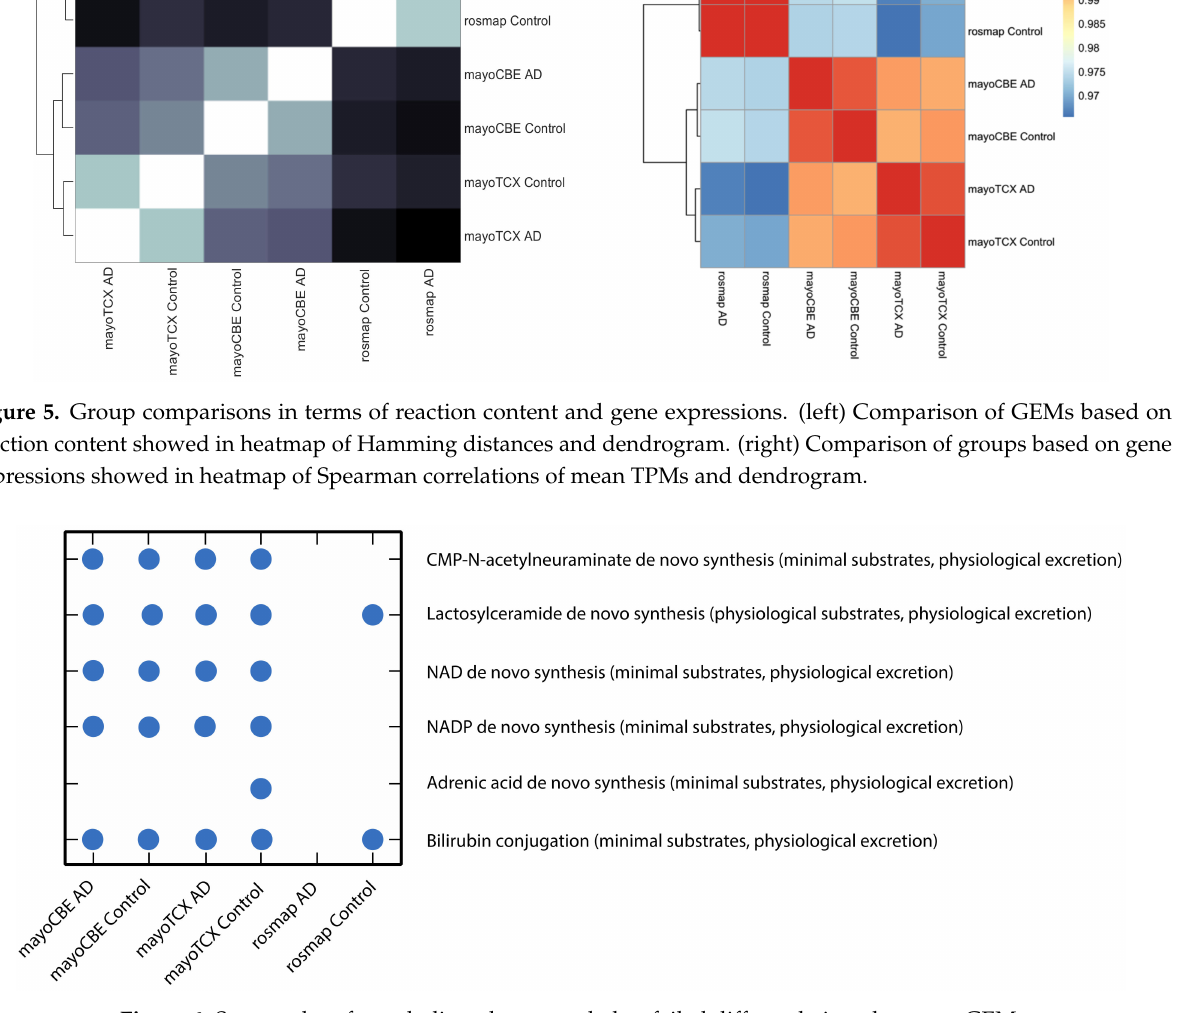
Figure 6. Scatter plot of metabolic tasks succeeded or failed differently in at least one